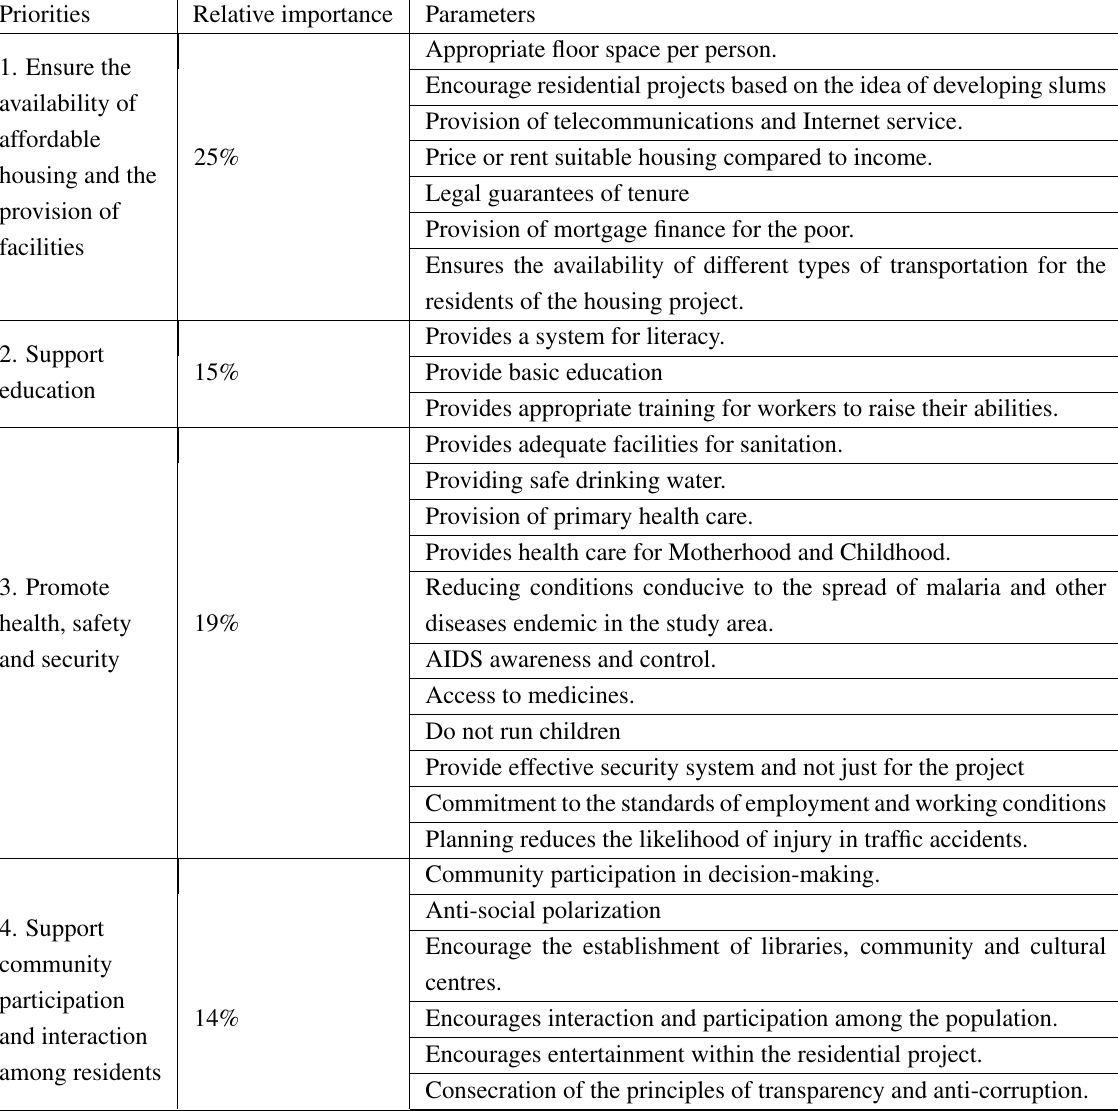
Table 2. Sustainable Social Housing Priorities, relative importance and parameters in